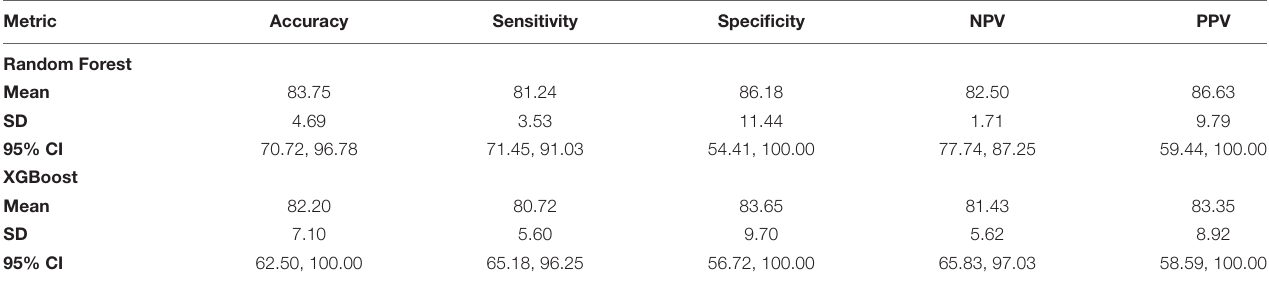
TABLE 5 | Measures of validity in the different evaluations performed in the cross